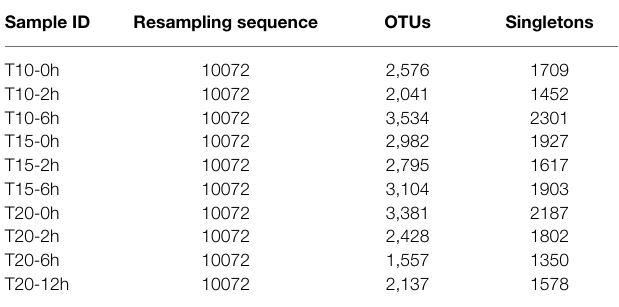
TABLE 4 | Number of Operational Taxonomic Units (OTUs) detected in O. stewarti juveniles under different durations of heat